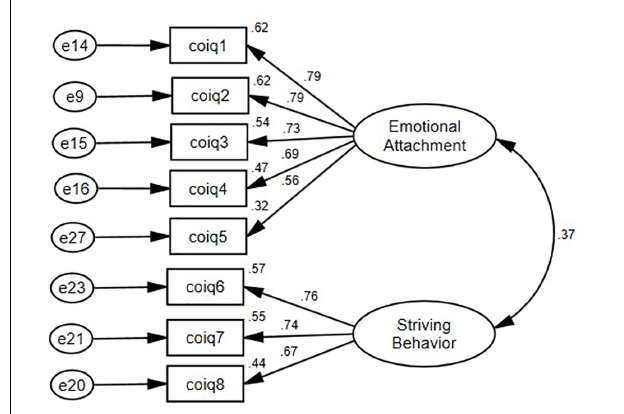
FIGURE 1 | Model specification of the 8-item, bi-dimensional Chinese Organizational Identification Questionnaire (Study